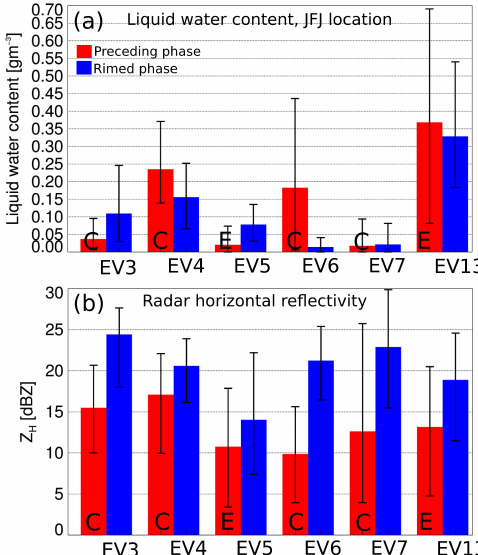
Figure 5. As in Fig. 4 but for Z H and LWC. (a) Liquid water content LWC (gm − 3 ) measured at the JFJ location. (b) Radar horizontal reflectivity factor Z H (dBZ) from altitudes around the JFJ location: 3580 ±